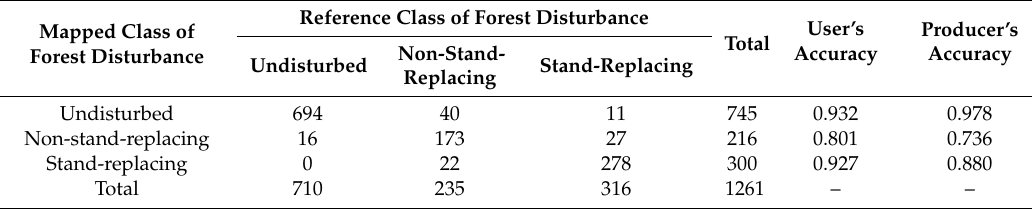
Table 5. The error matrix of LTS-derived dNBR classes of disturbance for forested areas.